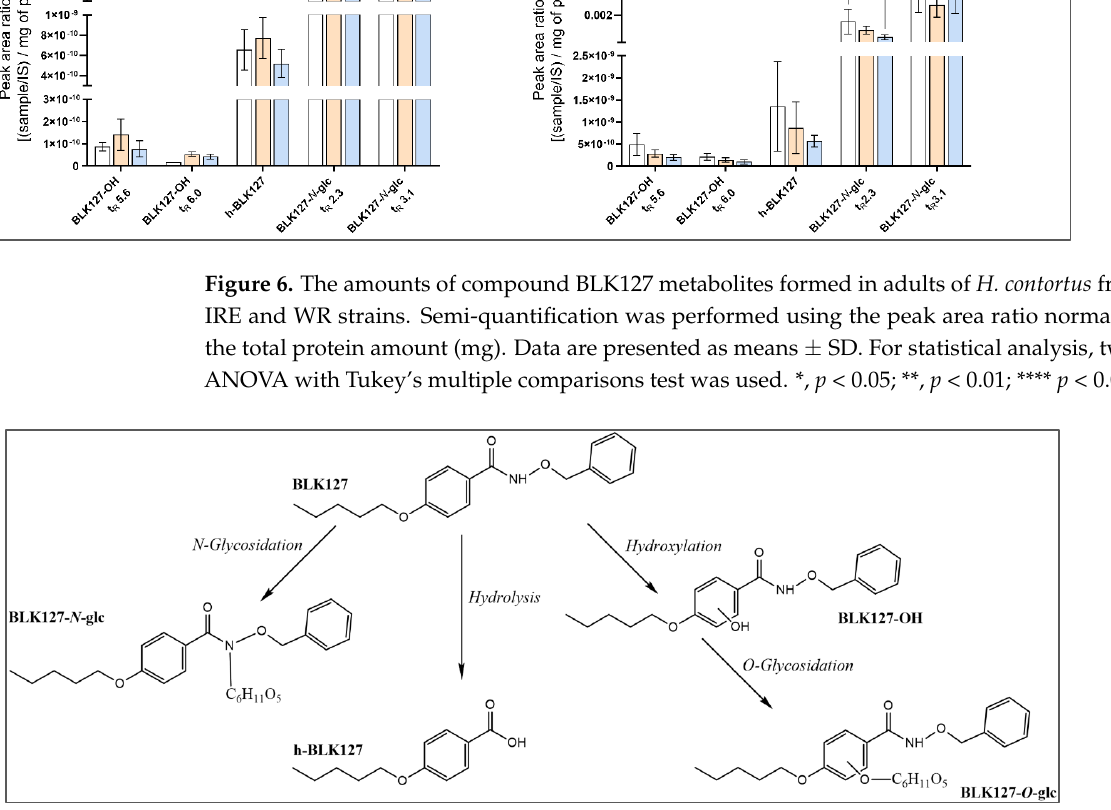
Figure 7. The proposed metabolic pathways of compound BLK127 in H. contortus adults.